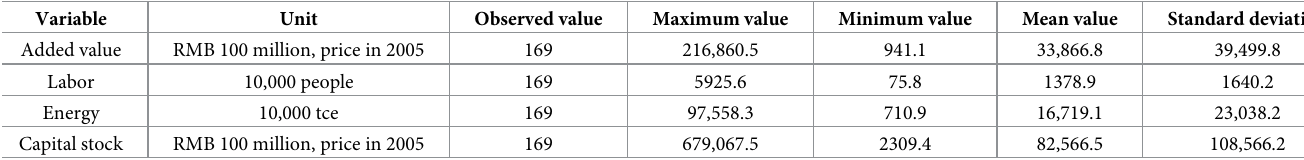
Table 2. Descriptive statistics of subsector